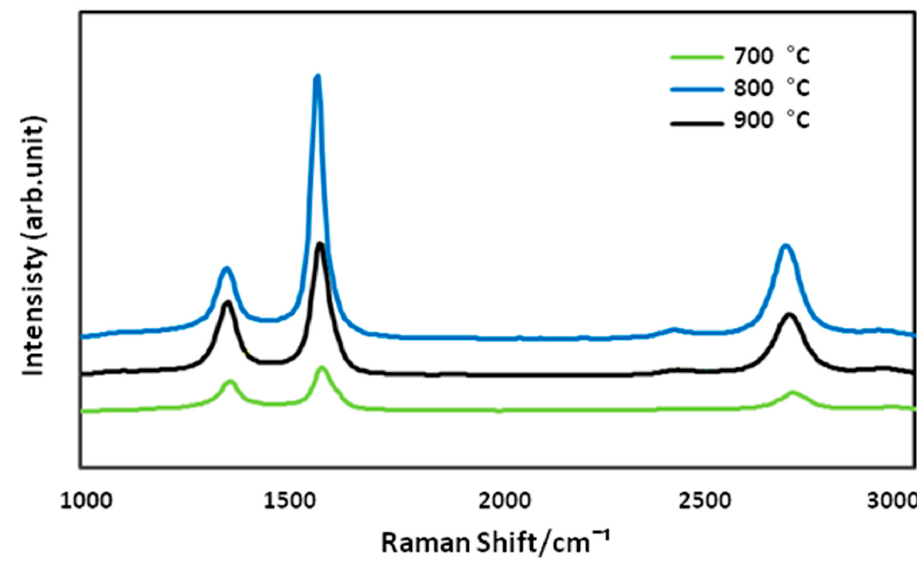
Figure 5. Raman spectra of the CNFCMs synthesized at various temperatures.